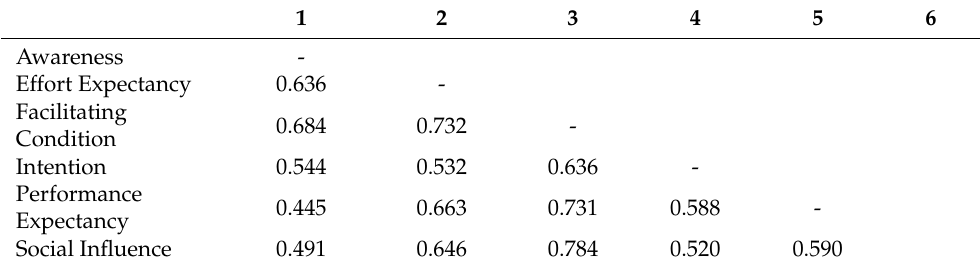
Table 3. Measurement Model: Discriminant Validity (HTMT